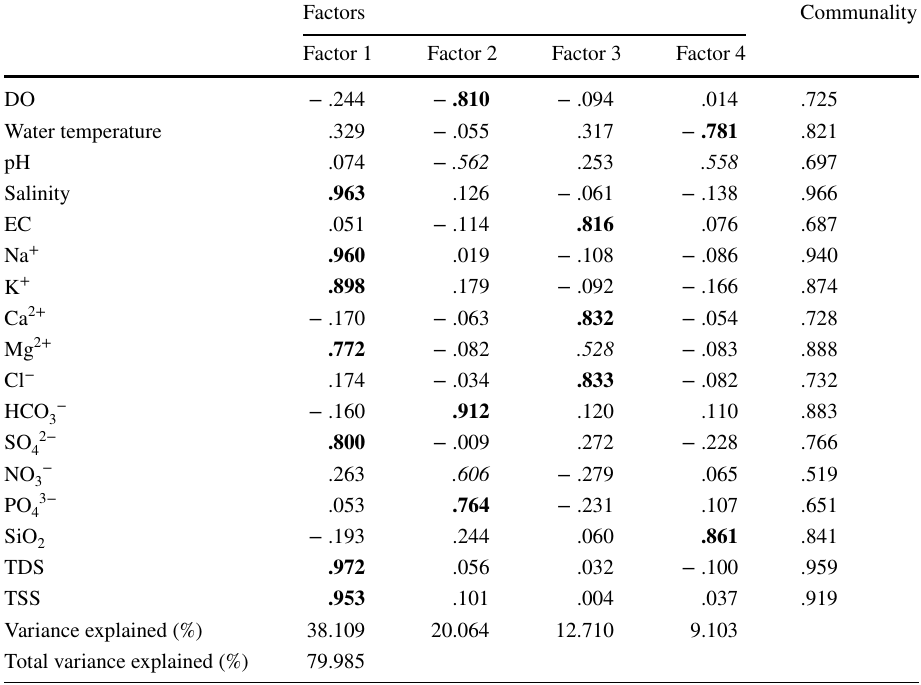
loading matrix from principal component analysis of physical parameters and major ions ( n =